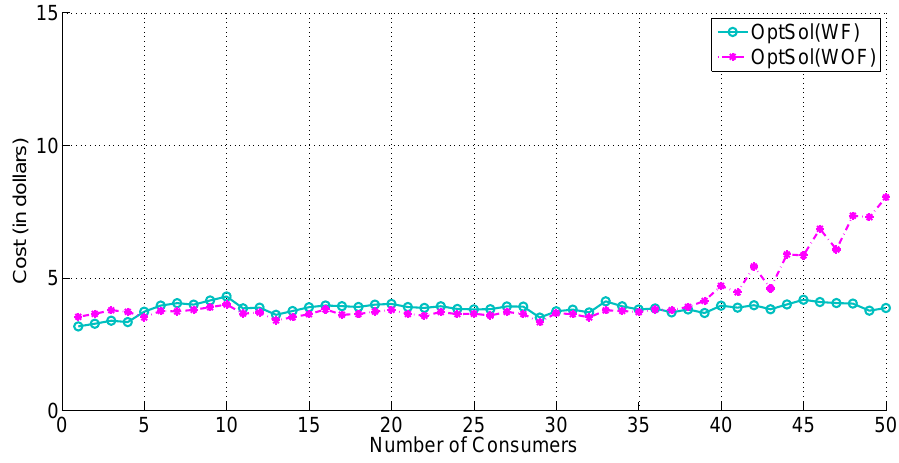
Figure 11. Cost Comparison of both Proposed